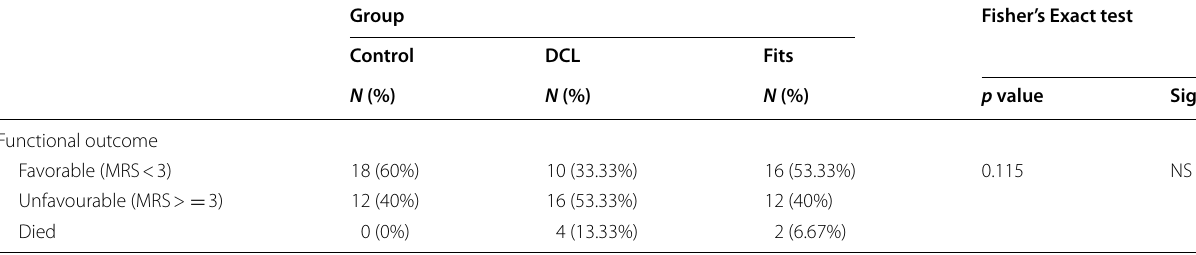
Table 6 Difference in functional outcome during discharge of the patients in the three